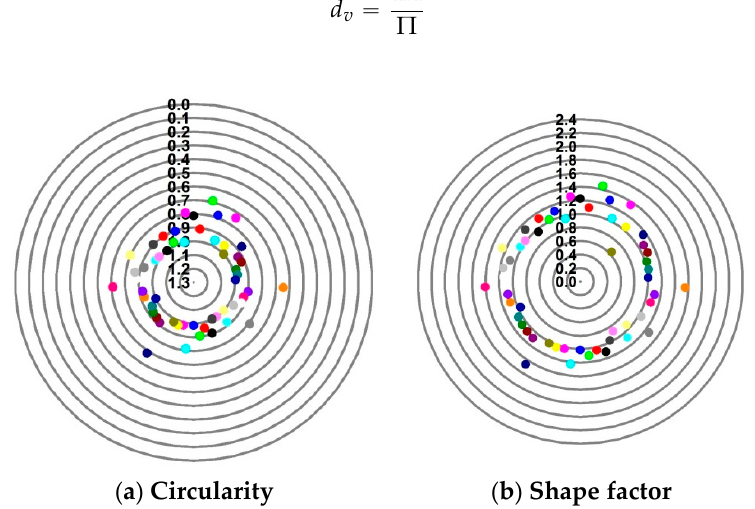
Figure 4. ( a ) Circularity C ; and ( b ) shape factor S of the microvoids extracted from the microstructures.